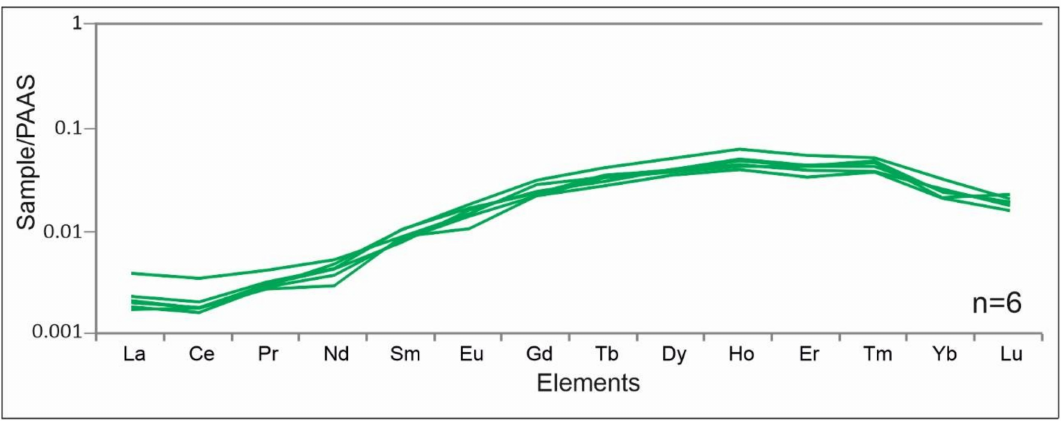
Figure 3. Post Archean Australian Shale normalized REE distribution patterns of fluorite samples from P é csely.